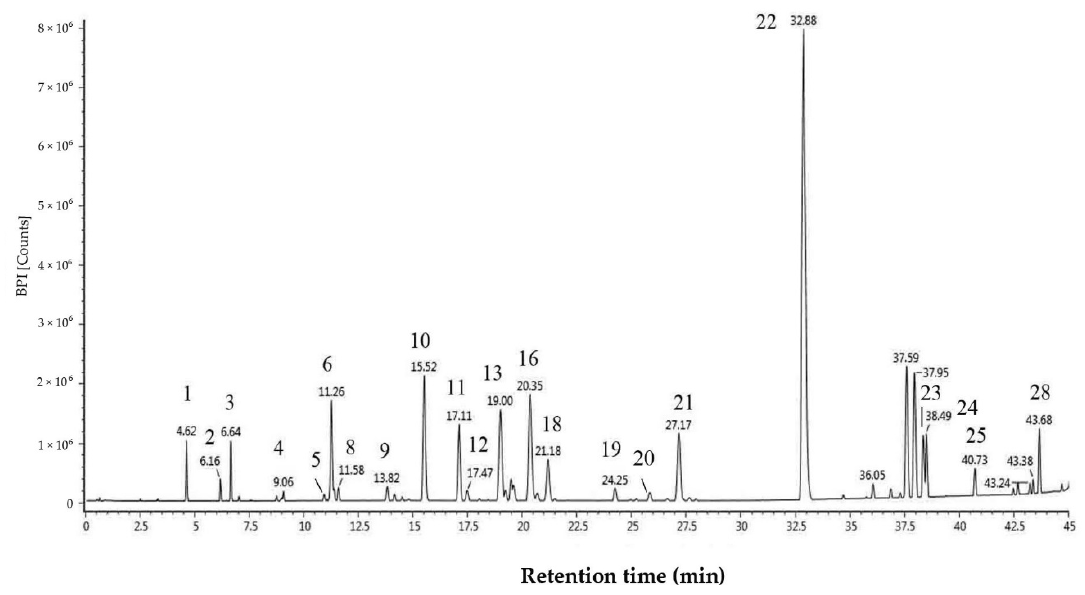
Figure 1. Chromatographic profile of 5 ‐ isoprenyl caffeic acid p ‐ coumaric acid ester in Brazilian propolis.